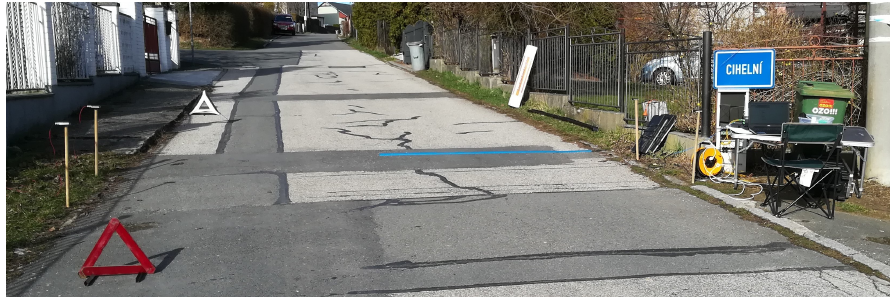
Figure 5. Example of measuring station in suburban part of Ostrava.